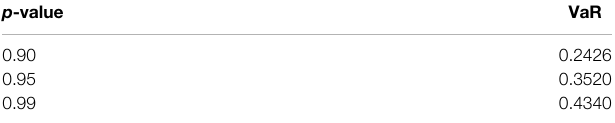
TABLE 7 | Threshold calculation